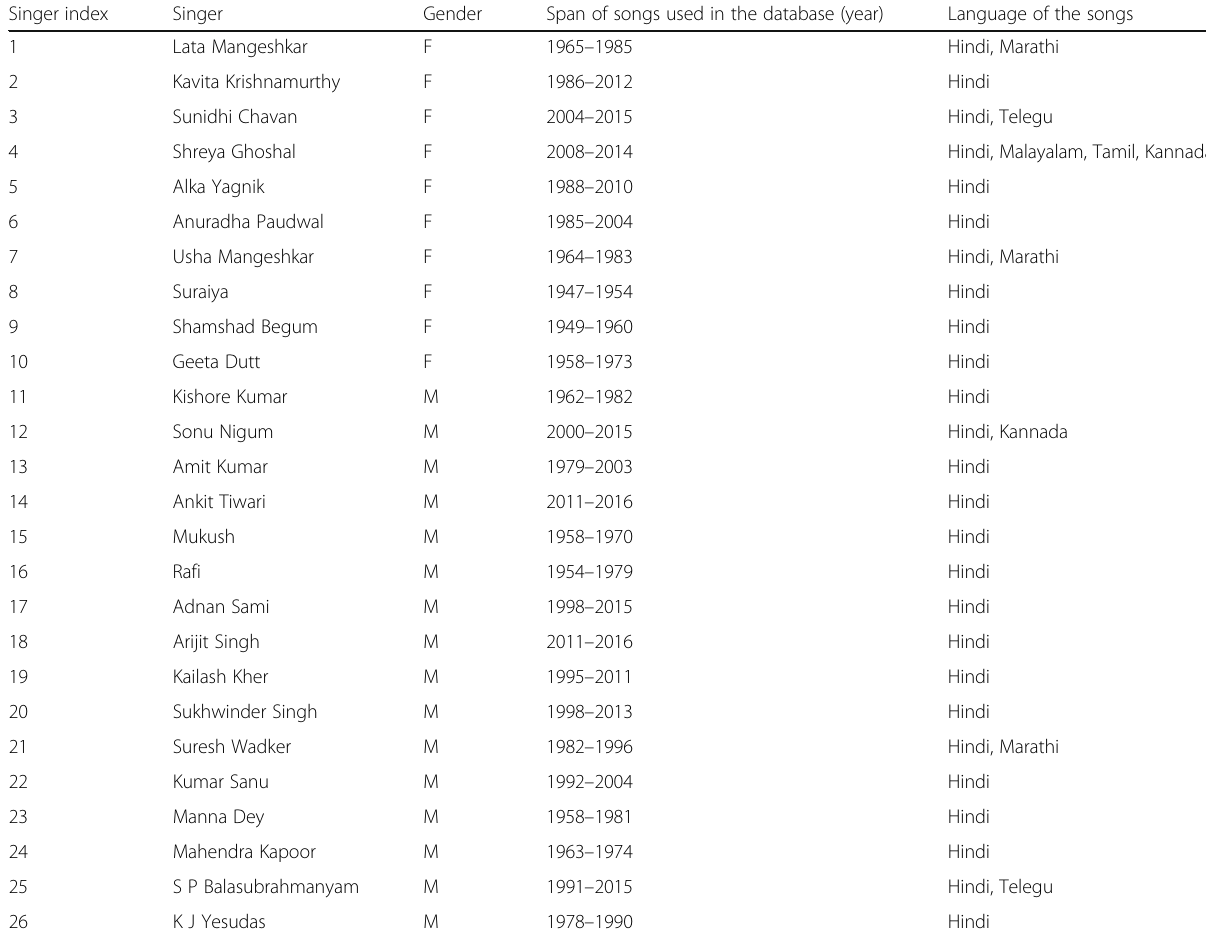
Table 1 List of singers used in SID Experimentation Singer